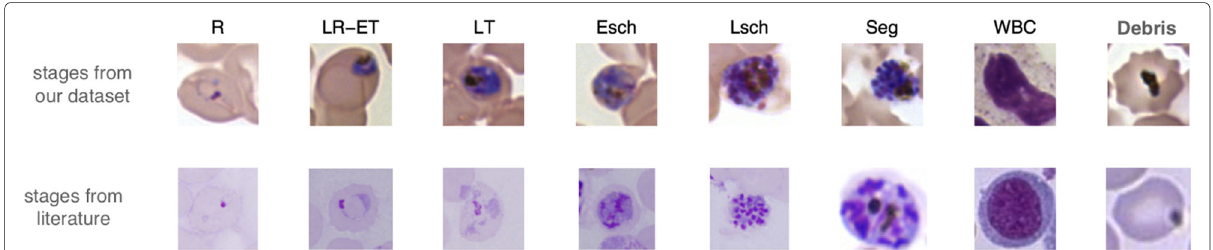
Fig. 1 Stages of malaria parasite from our data set and literature [17]. See text for explanation of abbreviations